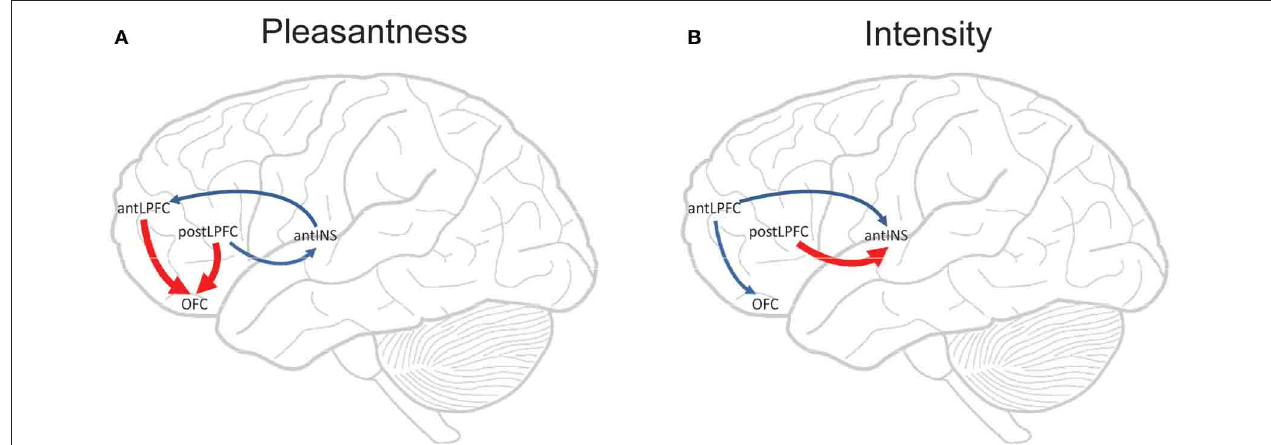
addition to significant causal influences (i.e., a significant cross-componential Granger causality that is different in the two directions). The areas are anterior (mean y ≈ 50) and posterior (mean y ≈ 37) lateral prefrontal cortex (antLPFC, postLPFC); orbitofrontal cortex secondary cortical taste area (OFC); and anterior insular cortex primary cortical taste area (antINS). [Reproduced with permission from Ge et al.